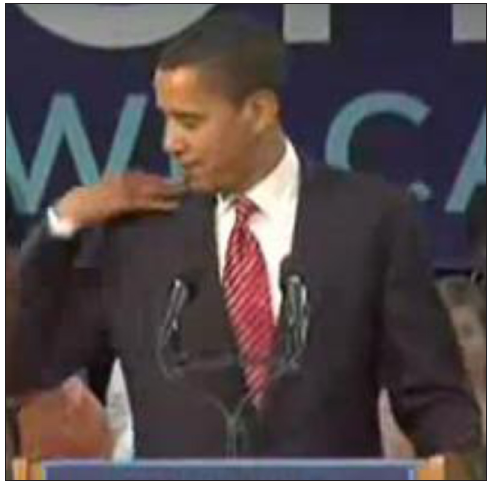
Figure 6: Obama brushes off the dirt, April 17, 2008 (CNN